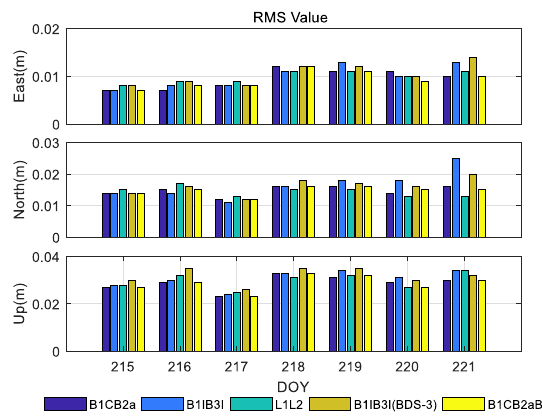
Figure 6. TGCU–TGBU (30 km) medium baseline RTK positioning accuracy. Figure 6. TGCU – TGBU (30 km) medium baseline RTK positioning accuracy. Table 6. TGCU – TGBU (30 km) average of medium baseline RTK RMS and ambiguity fixing rate.